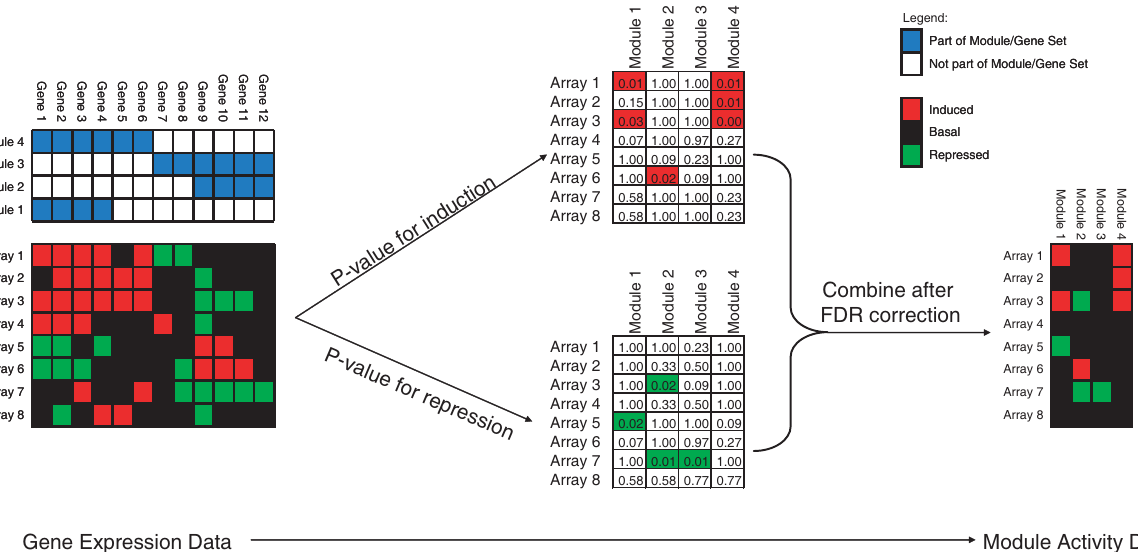
Figure 4. Converting gene expression data into module activity data. For a given gene expression dataset, and a set of modules we assessed the statistical significance of the overlap of induced/repressed genes with the modules using the hypergeometric distribution. This leads to two p-values for each array/module pair. These p-values are combined into a single discrete module activity score.